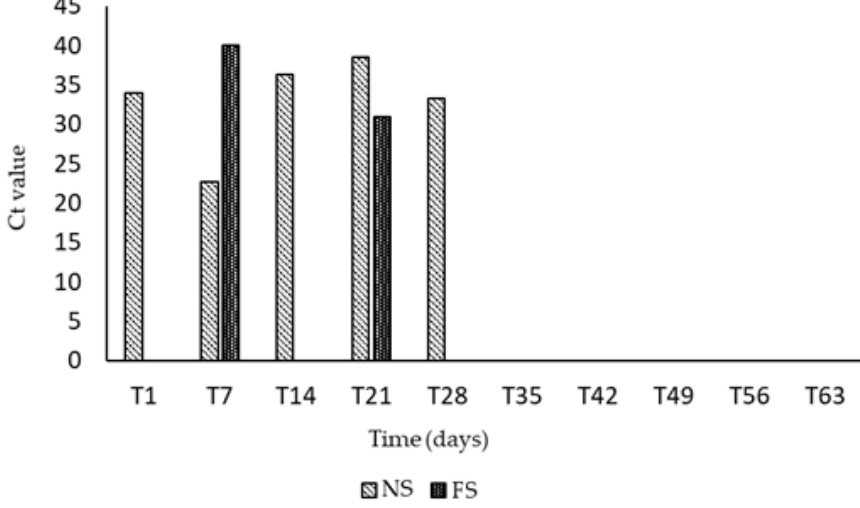
Figure 1. Weekly virological monitoring of BCoV RNA detected in NSs and FSs. BCoV RNA was revealed intermittently from T1 to T28 in the nasal secretions, and from T7 to T21 in the feces.